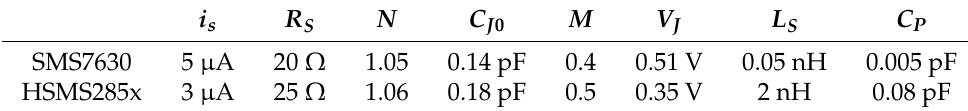
Table 1. Parameters of two types of Schottky diode that are considered in the